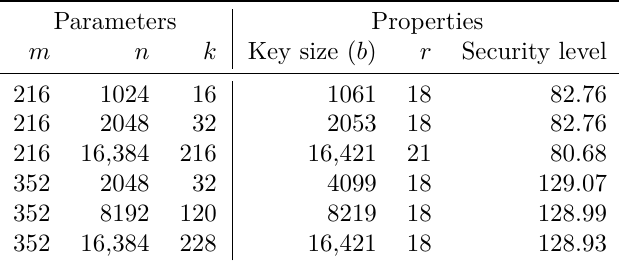
Table 1: Firekite’s parameters for 80 and 128-bit security with the properties in terms of key size b , and number of randomization rounds r